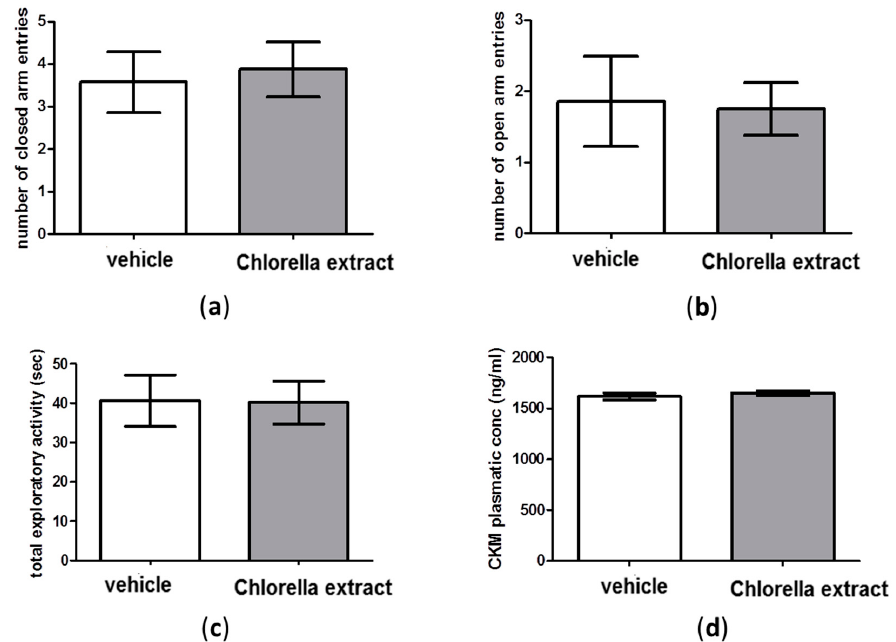
Figure 2. Evaluation of locomotion parameters in male Wistar rats after Chlorella sorokiniana extract or vehicle administration. ( a ) Number of closed arms entries and ( b ) number of open arms entries in the elevated plus-maze test; ( c ) total exploratory activity in the novel object recognition test; ( d ) plasma CKM concentrations Wistar rats after Chlorella sorokiniana extract (Chlorella extract, 30 mg/kg/mL dark bar) or vehicle (sunflower oil 1 mL/kg, empty bar) administration. Data are expressed as mean ± SEM ( n = 8 per